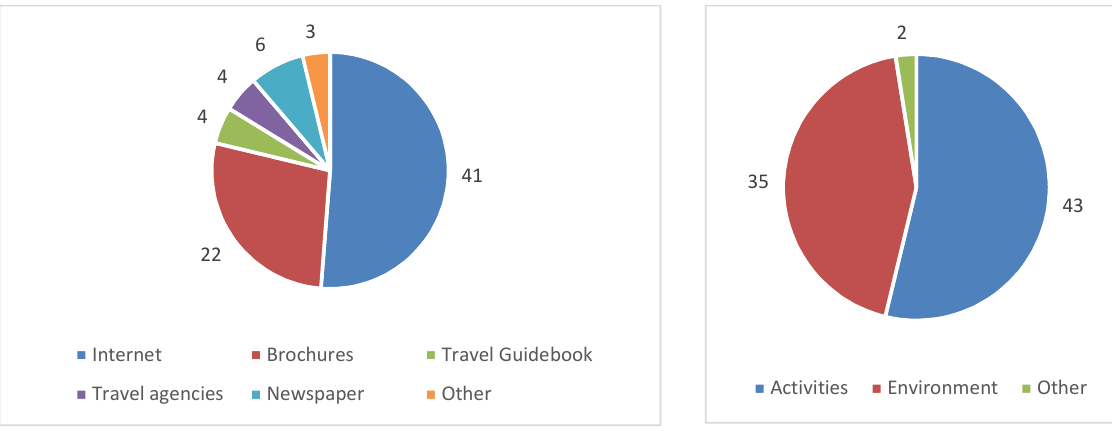
Fig. 2. Reason and method of finding information about Homestay